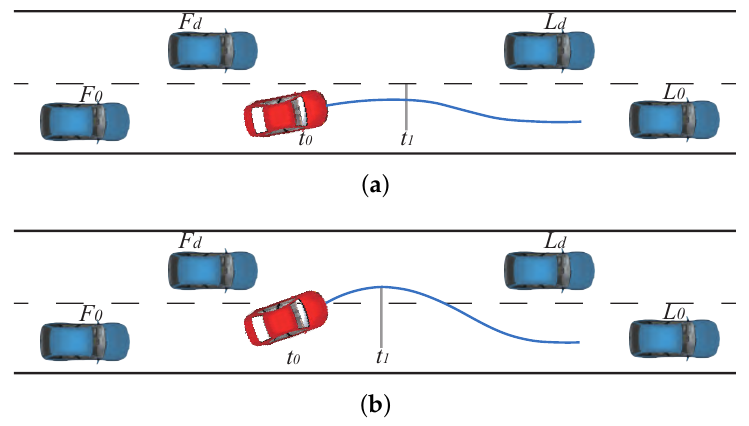
Figure 8. The stages for lane-change abortion. ( a ) The first case, the host vehicle cancels the lane- change maneuver in a lane-keep mode. ( b ) The second case, the host vehicle cancels the lane-change maneuver in a lane-change mode.